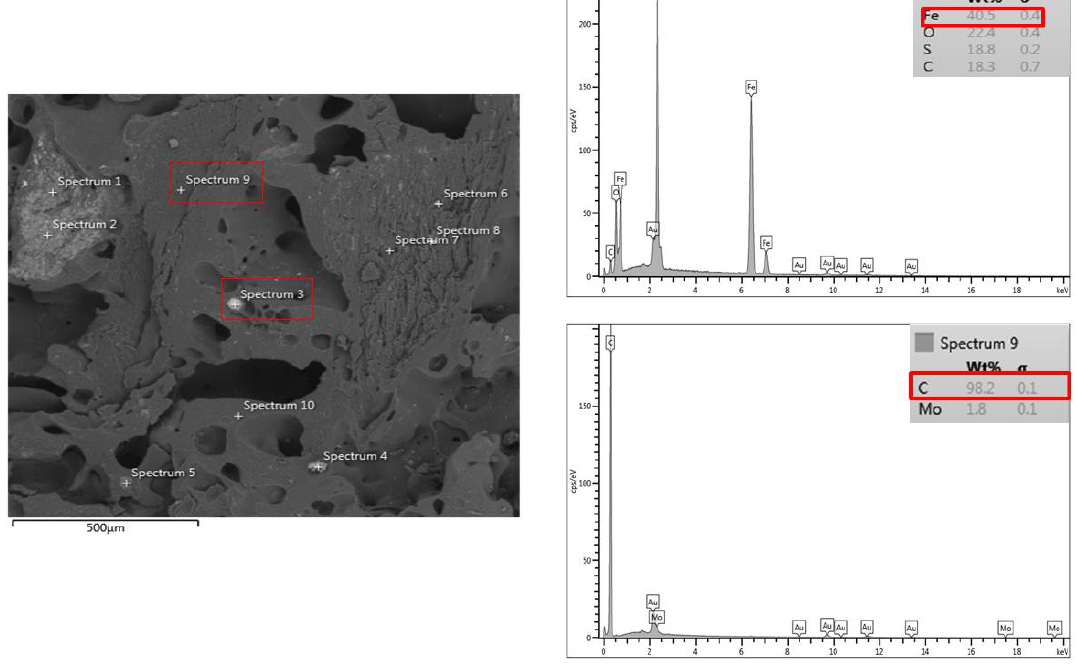
Figure 9. EDS analysis of coke with steel mesh to eat coke condition of MT